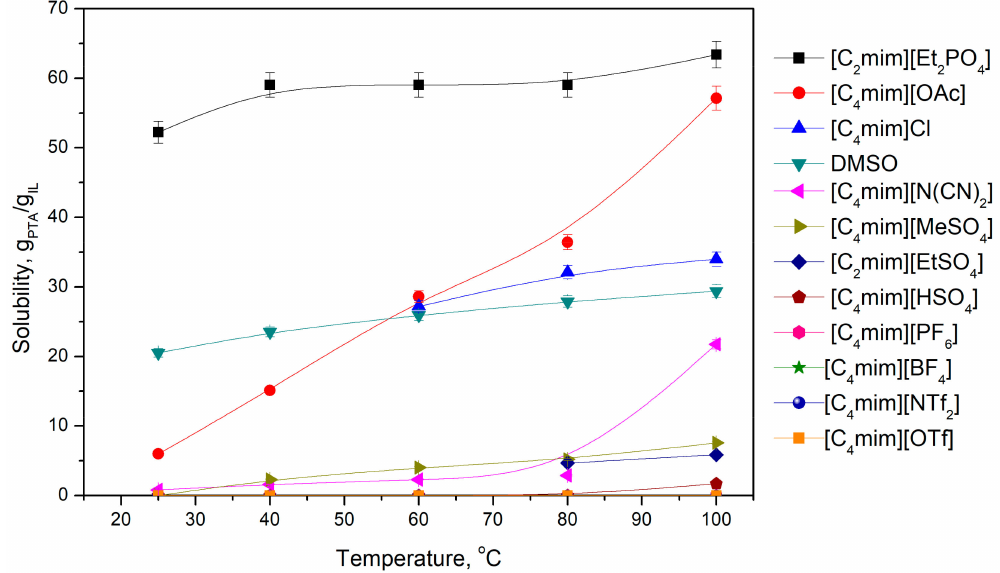
Figure 4. The influence of anion structure on the solubility of